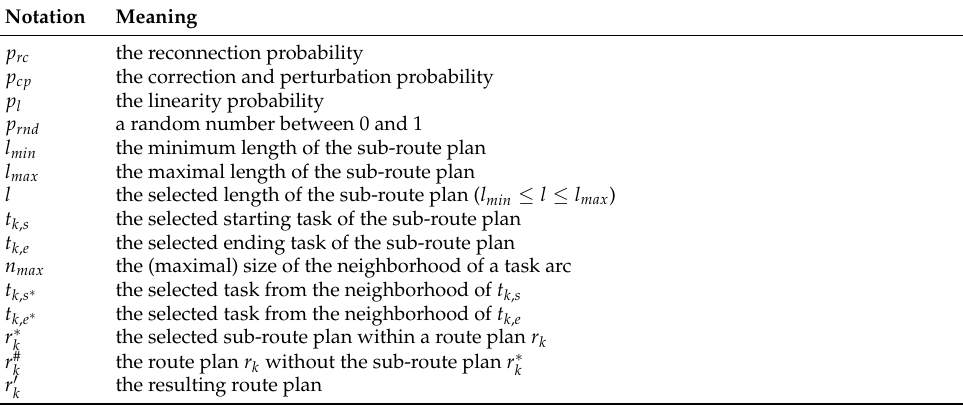
Table A3. Notations used in the description of the sub-route plan